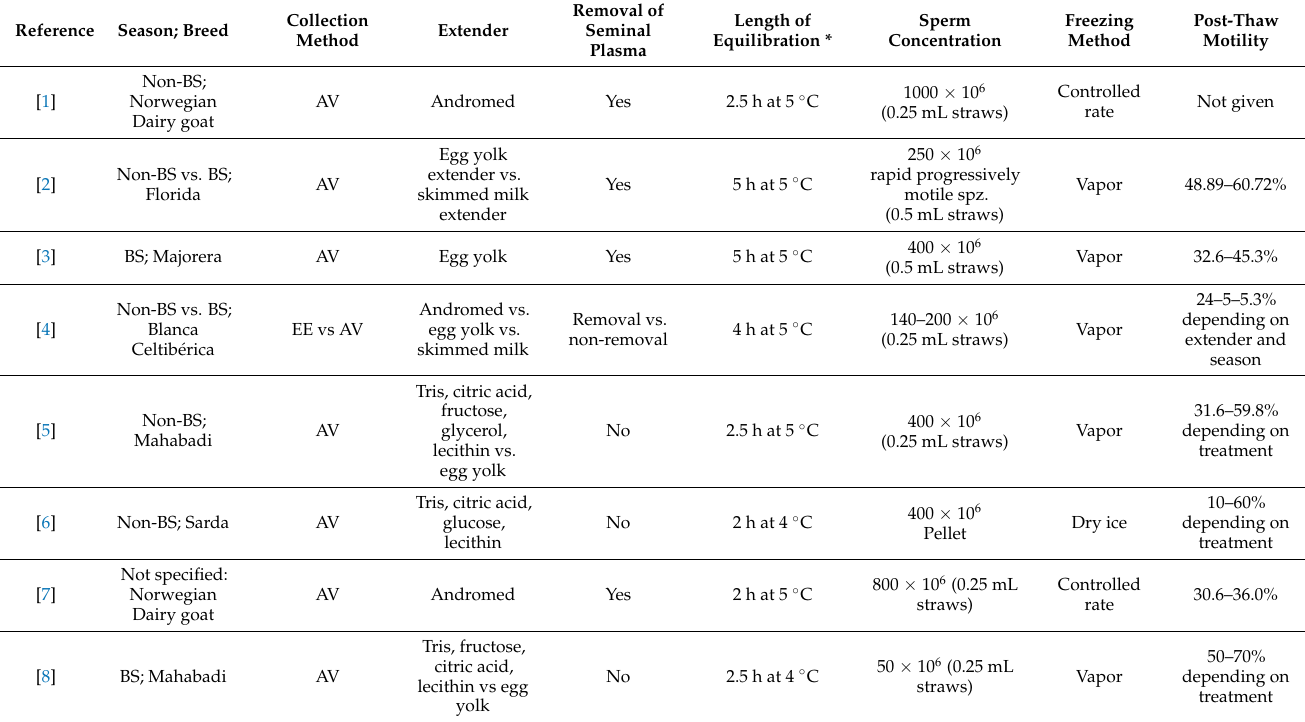
Table 1. Comparison of various protocols for freezing goat